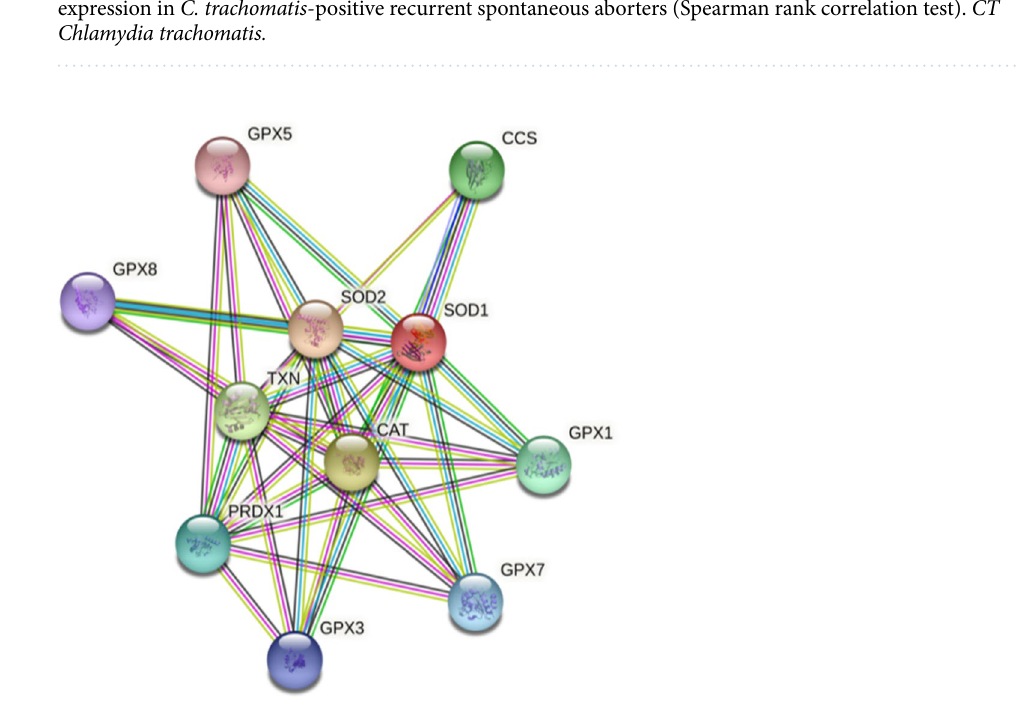
Figure 6. Predicted interacting partners of SOD1 and SOD2